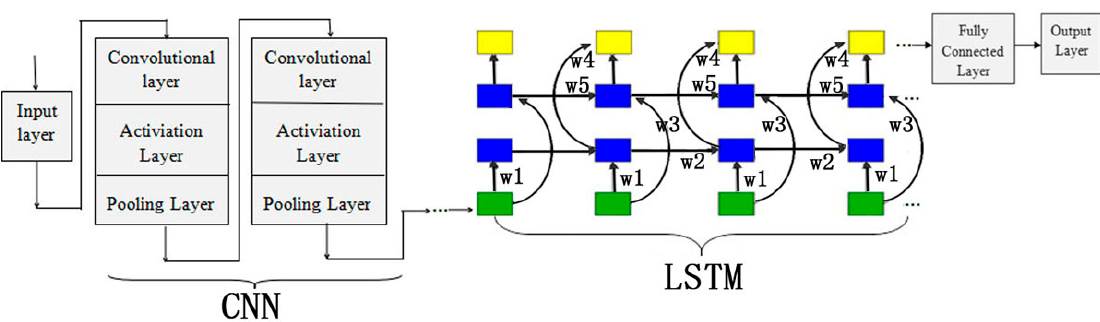
Figure 1. Architecture of CNN+LSTM for predicting phosphorylation sites. CNN: convolutional neural network; LSTM: long short-term memory network. Gray squares represent the layers of CNN; Green squares represent the first layers of LSTM; Blue squares represent the hidden layers of LSTM; Yellow squares represent the output layers of LSTM.